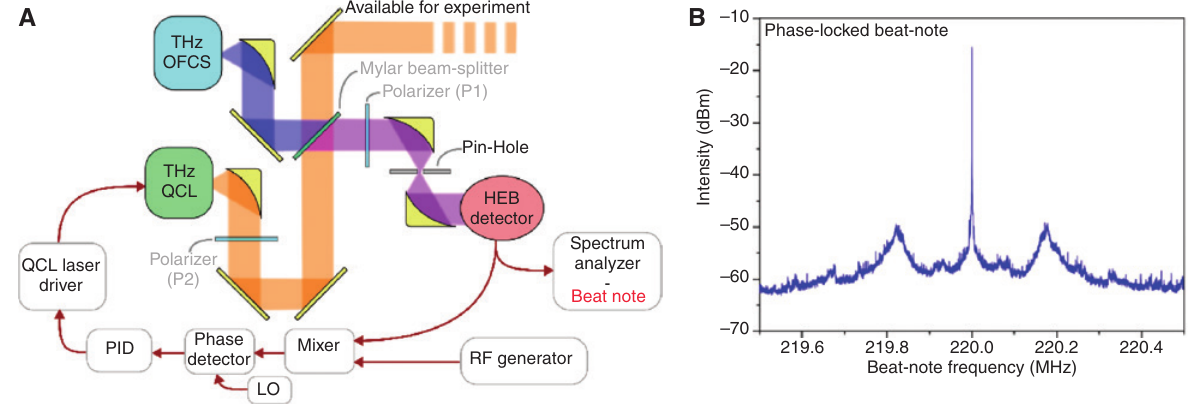
Figure 15: Phase locking of a THz QCL to a free-standing THz frequency comb. Left: The beating between the QCL and the FCS is detected on a HEB. The two beams are superimposed by means of a highly asymmetrical beam splitter, so that more than 99.5% of the QCL radiation is available for the experiment beam. The P1 polarizer ensures polarization matching between the beams, whereas P2 selects the amount of QCL power to be sent to the HEB. A sketch of the electronic setup is given in the lower part of the panel. Right: beat-note spectrum when the QCL is phase-locked to the comb tooth. Reprinted with permission from [133], copyright